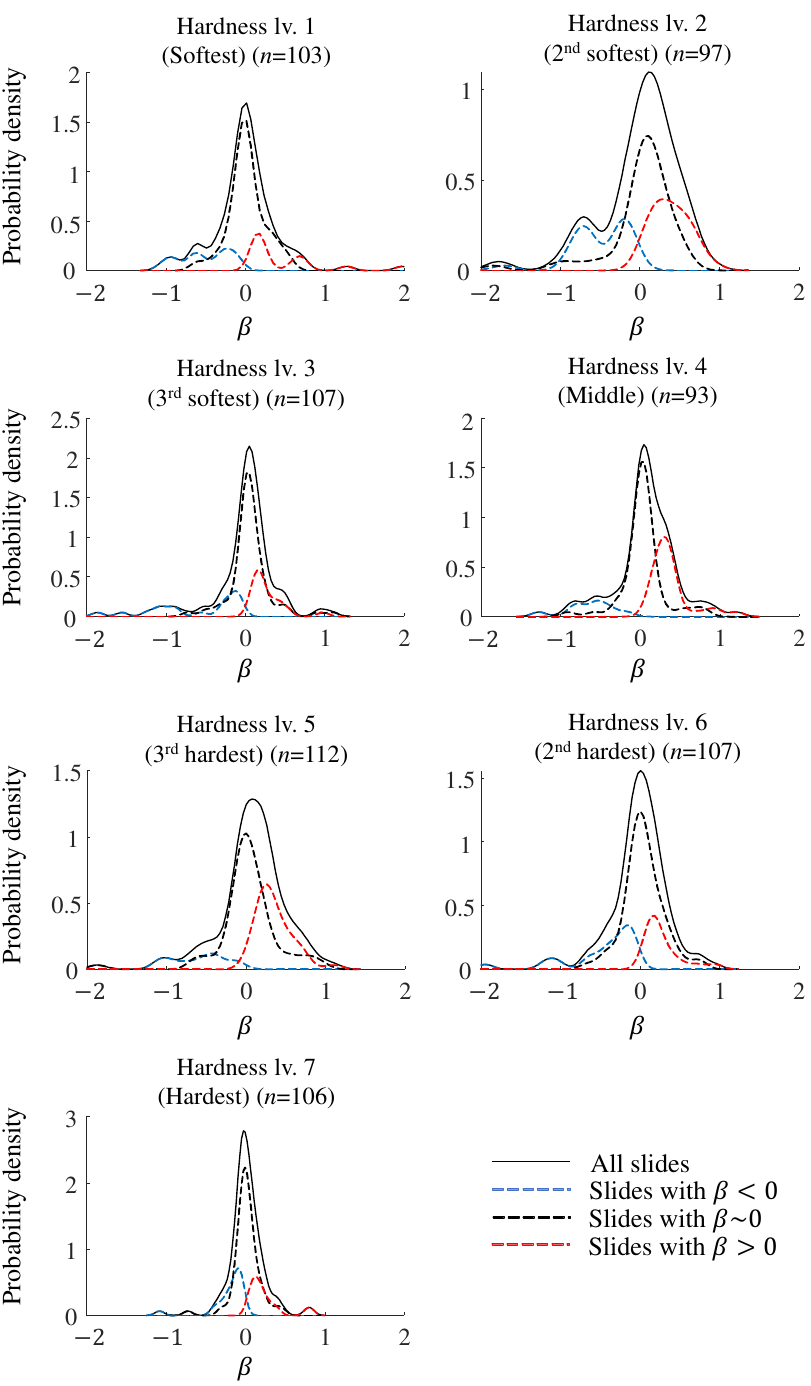
Figure 5. Probability density functions of β under case 2 (ethanol condition). Solid lines include all the slides, and red, blue, and black dotted lines are the distributions of positive, negative, and insignificant β ( β ∼ 0), respectively. d = 0.8 for categorizing the sign of β